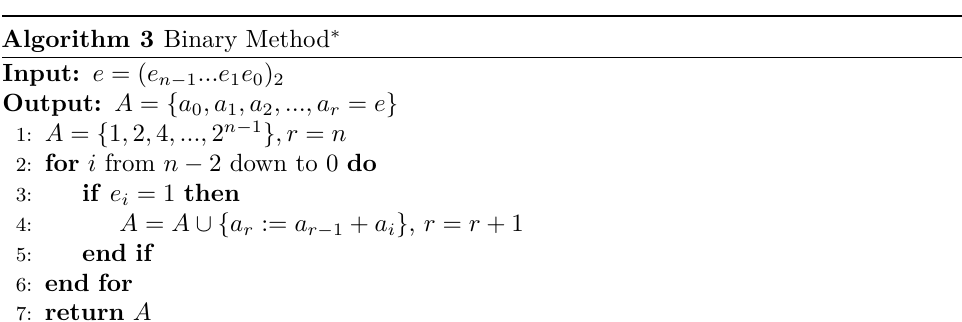
Algorithm 3 Binary Method